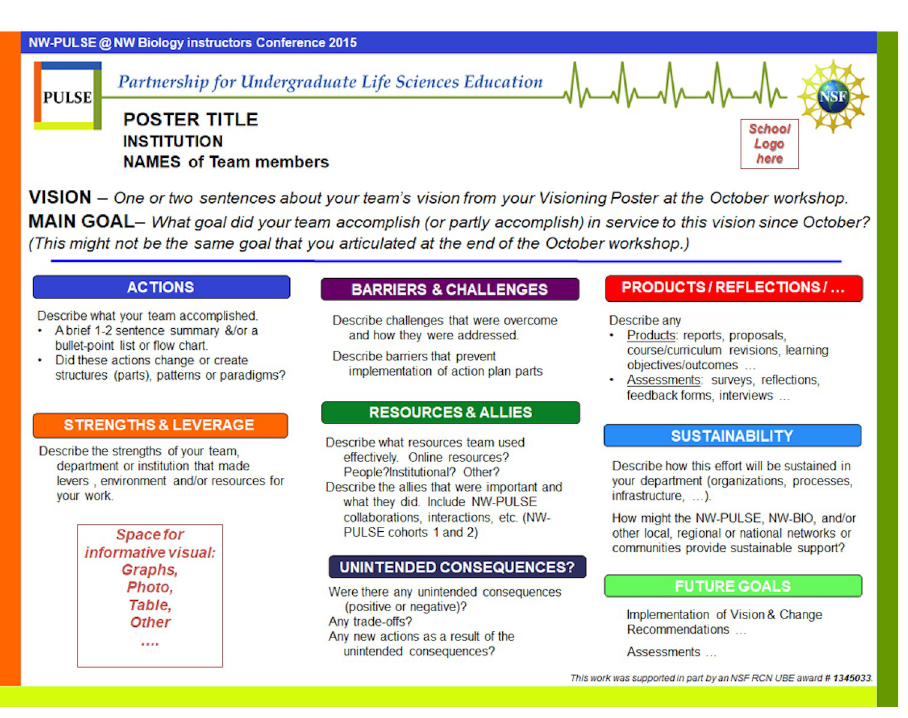
Fig 5. The poster template used for the reporting of progress towards departmental transformation at the May NW BIO conference.